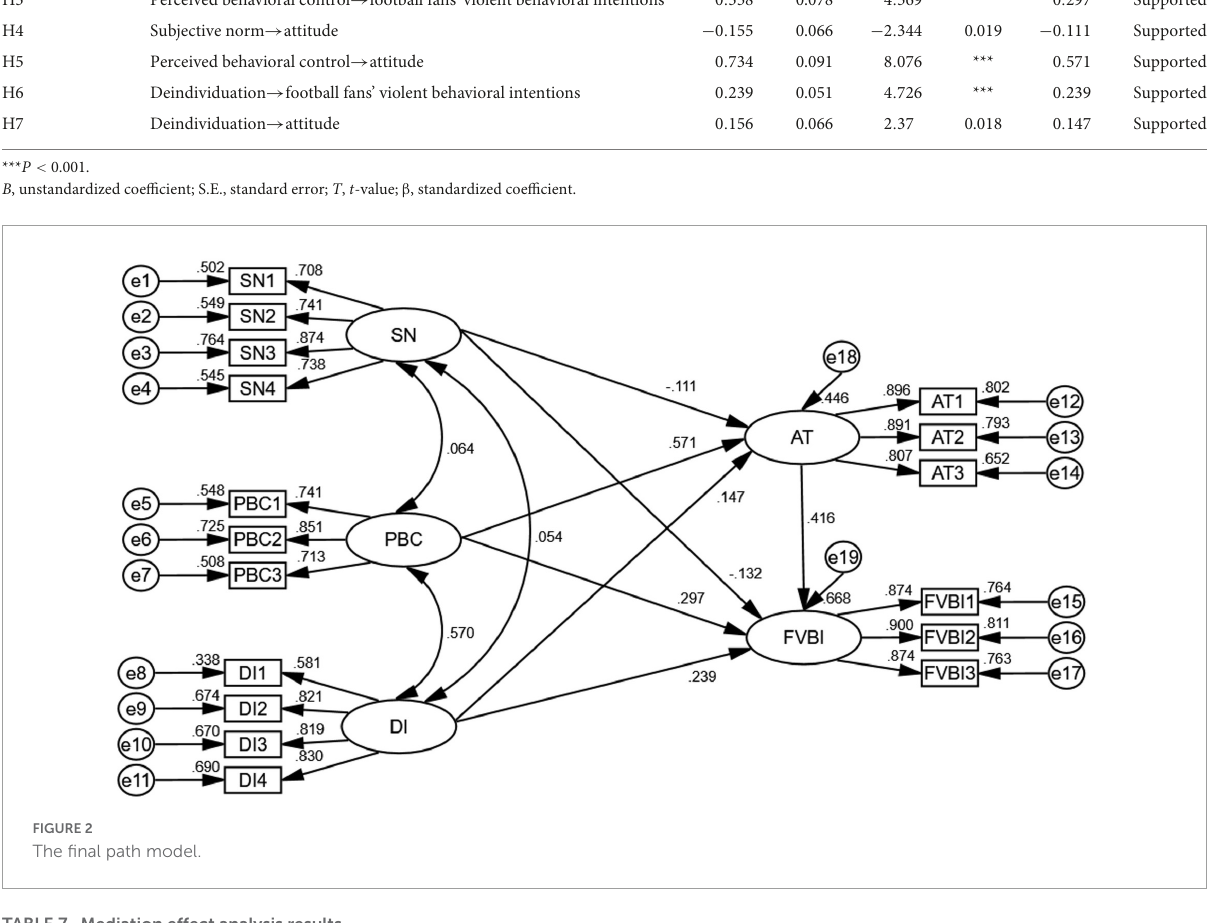
TABLE 7 Mediation effect analysis